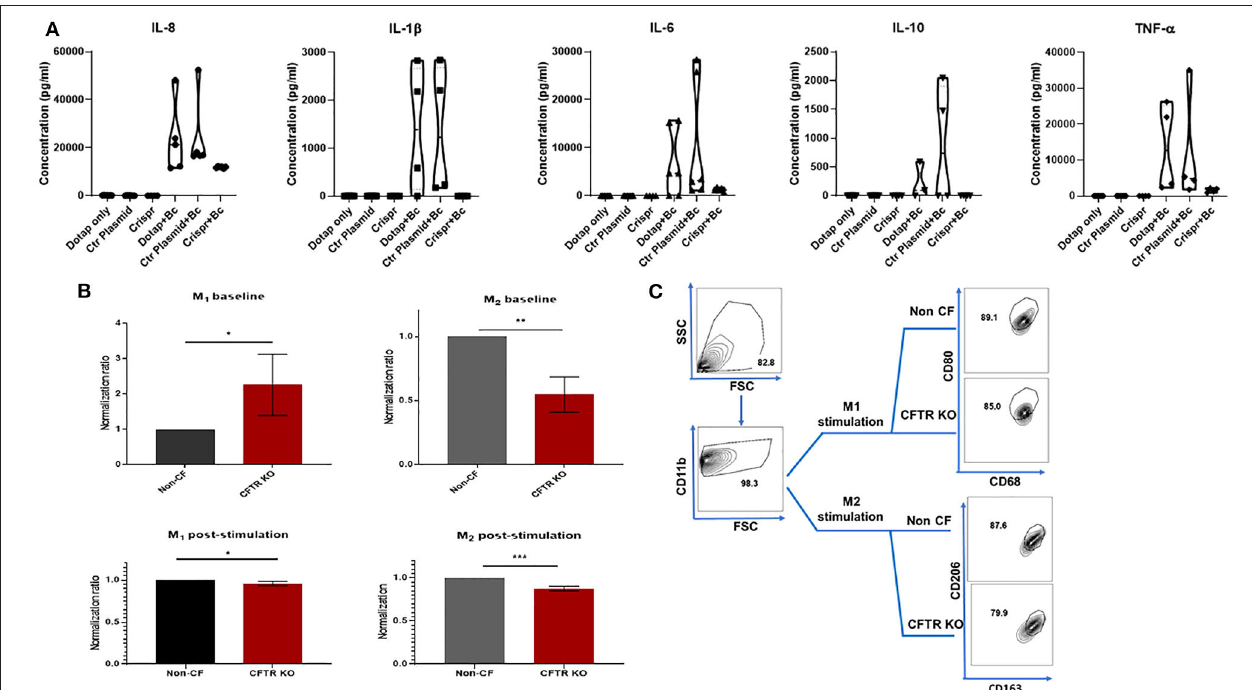
FIGURE 5 | CFTR KO is associated with decreased cytokine and polarization responses. (A) Violin plots for IL-8, IL-1 β , IL-6, IL-10, and TNF- α cytokine production. Cytokines were measured in macrophage supernatants at baseline for three conditions (DOTAP medium alone, transfection with an empty vector [Ctr plasmid], or CFTR KO [Crispr]). Cytokines were also measured during infection with B. cenocepacia (Bc) for the same three conditions as occurred at baseline. Significance determined via one-way ANOVA for baseline or infected conditions. n = 4–7 per group. (B) M1 (%CD68 + CD11b + CD80 + ) and M2 (%CD11b + CD163 + CD206 + ) polarization of non-CF and CFTR KO MDMs without a polarizing stimulus (top, baseline), and after 48h exposure to a polarizing stimulus (bottom, post-stimulation). Data were normalized to non-CF MDMs. n = 4, mean ± SD. * p < 0.05, ** p < 0.01, *** p < 0.001, via unpaired t -test. (C) FACS gating strategy for 5B post-stimulation studies. M1 & M2 MDM subsets were sequentially gated on FSC/SSC, CD11b, and CD68 + CD80 + (M1) or CD163 + CD206 + (M2). Gating for M1 and M2 baseline from 5B was the same except for lack of M1/M2